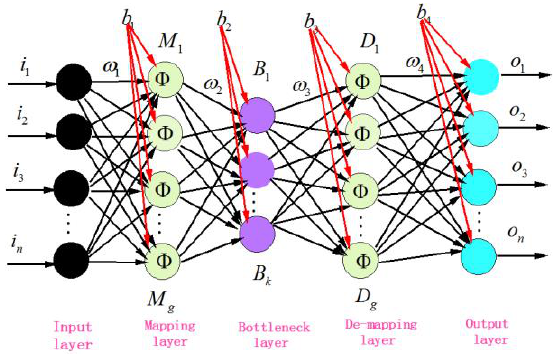
Figure 2. Schematic of the structure of the AANN model.